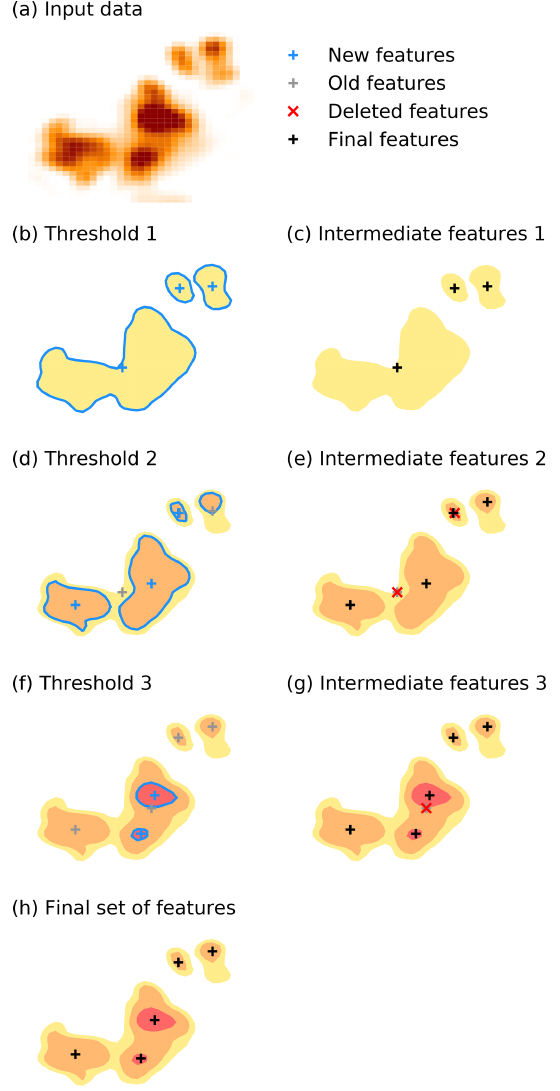
Figure 2. Schematic illustration of the multi-threshold feature de- tection approach using three different threshold values.